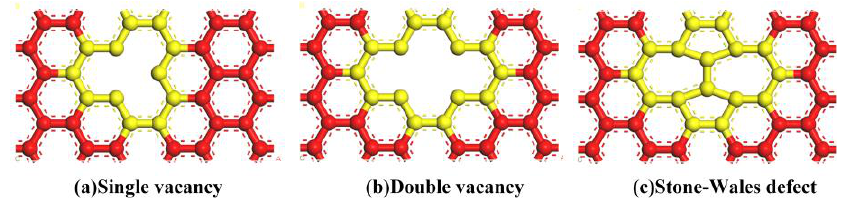
Figure 2. Types of defect studied in this work: ( a ) Single vacancy (SV); ( b ) Double vacancy (DV); and ( c ) Stones–Wales (SW).